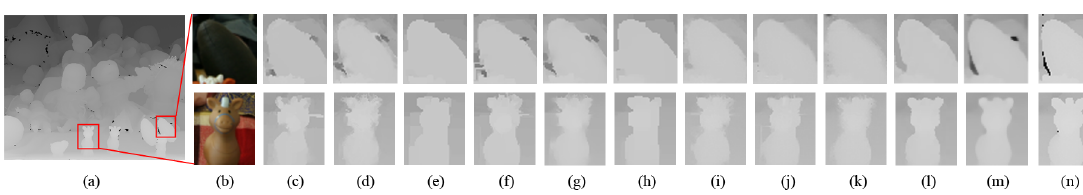
Figure 6. Example depth map SR results of Dolls with two ROI. ( a ) Ground truth depth map, ( b ) color regions, and SR results of ( c ) Diebel et al. [22] (BP% = 6.64) , ( d ) JBU [11] (5.55) , ( e ) Lu et al. [23] (6.69) , ( f ) Kim et al. [24] (4.37) , ( g ) Jung [17] (5.04) , ( h ) Lo et al. [3] (3.45) , ( i ) Park et al. [26] (5.07) , ( j ) Ferstl et al. [27] (2.80) , ( k ) Choi et al. [18] (3.17) , ( l ) Lo et al. [21] (1.78) , ( m ) Our method (1.74) , and ( n ) the associated ground truth.